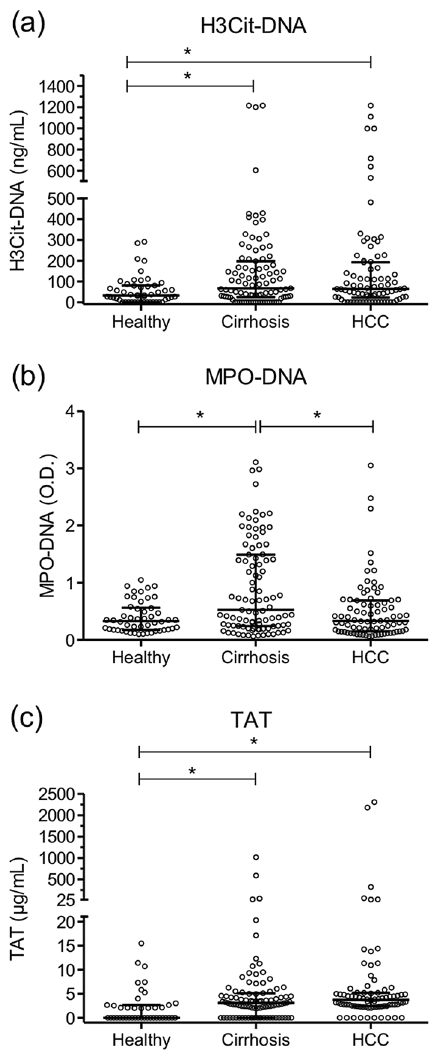
Figure 1. Plasma levels of H3Cit-DNA, MPO-DNA and TAT in patients with cirrhosis, HCC and in healthy controls. ( a ) Plasma H3Cit-DNA was significantly elevated in both the HCC and cirrhosis group as compared to healthy controls. ( b ) Plasma MPO-DNA was significantly increased in the cirrhosis group as compared to healthy controls and the HCC group. ( c ) Plasma TAT was significantly elevated in both the HCC and cirrhosis group as compared to healthy controls. Figures were created using GraphPad Prism version 5.04 for Windows, GraphPad Software, San Diego, California, USA, www. graph pad.